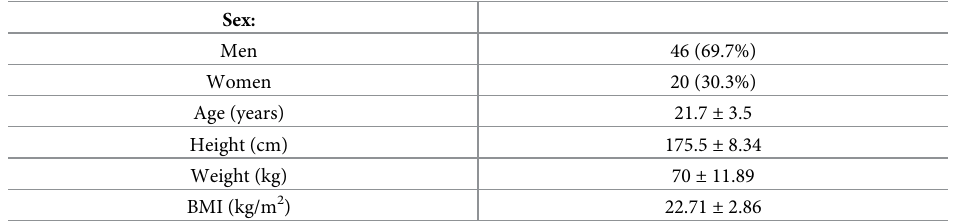
Descriptive results are shown as total number (percentage) and mean ( ± SD). Abbreviations: SD, Standard Deviation; n, number, %, percentage; cm, centimeters; kg, kilograms; m,